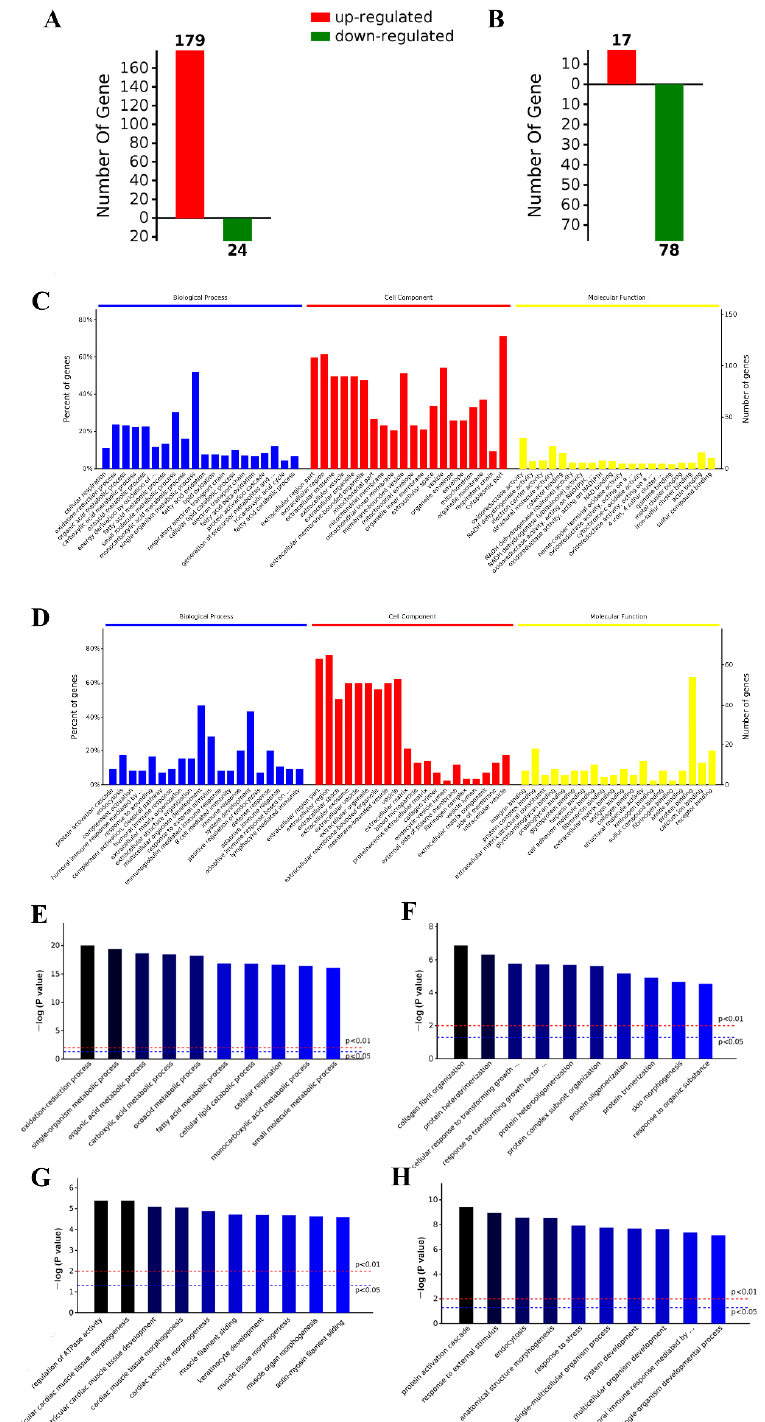
Figure 5. Aortic differentially expressed proteins were identified by the iTRAQ approach. HFD up- or down-regulated proteins (versus ND) ( A ). HFD-LI up- or down-regulated proteins (versus HDF) ( B ). GO enrichment analyses of the aortic differentially expressed proteins of HFD group versus ND group ( C ). GO enrichment analyses of the aortic differentially expressed proteins of HFD + LI group versus HFD group ( D ). GO enrichment analysis revealed the most relevant biological process (BP) terms of proteins up-regulated by HFD (versus ND) ( E ), proteins down-regulated by HFD (versus ND) ( F ), proteins up-regulated by HFD-LI (versus HFD) ( G ), and proteins down-regulated by HFD + LI (versus HFD) ( H ). Top 10 GO clusters ( p < 0.05). GO, Gene